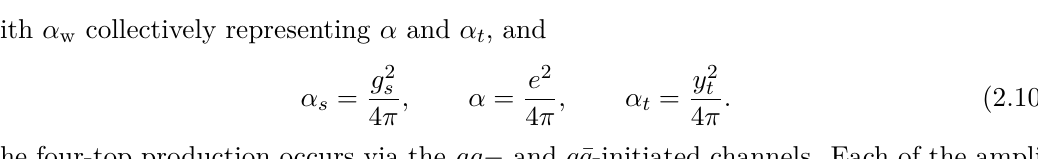
Figure 3 . Representative diagrams for four-top production with blobs representing the one dimension-six EFT insertion, in the gg -initiated production mode ( left ) and in the q ¯ q -initiated production mode ( right